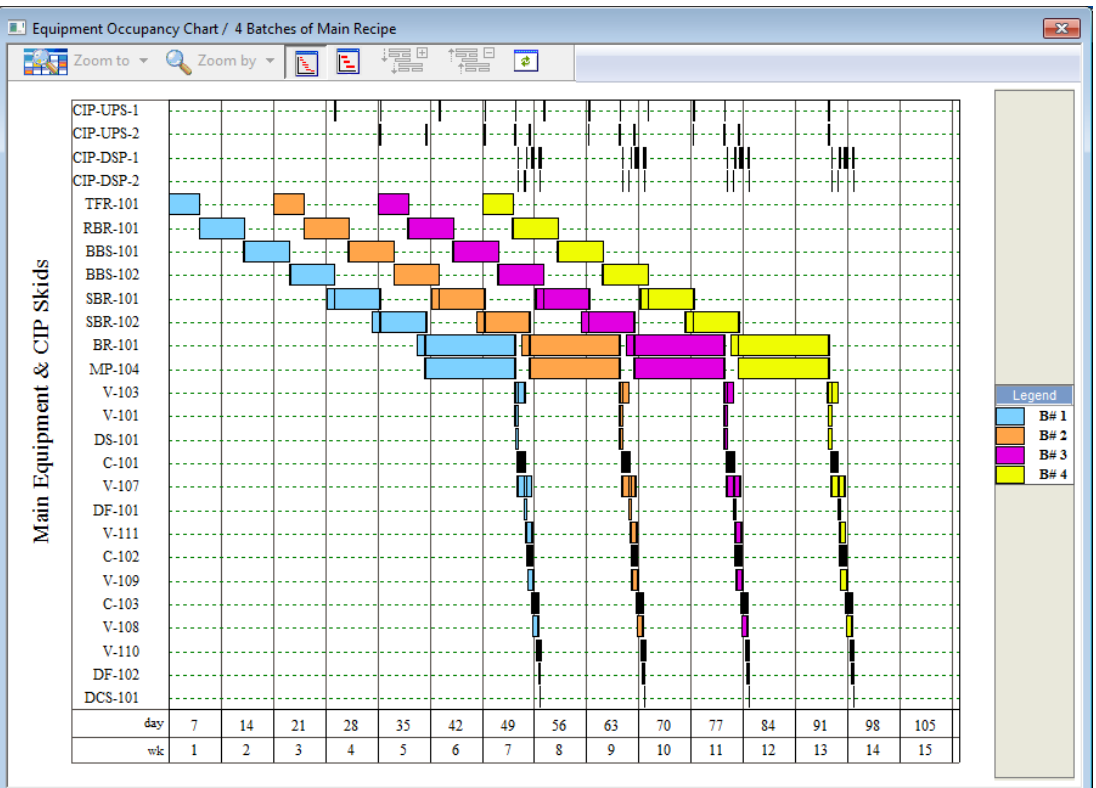
Figure 3. One bioreactor train feeding one purification